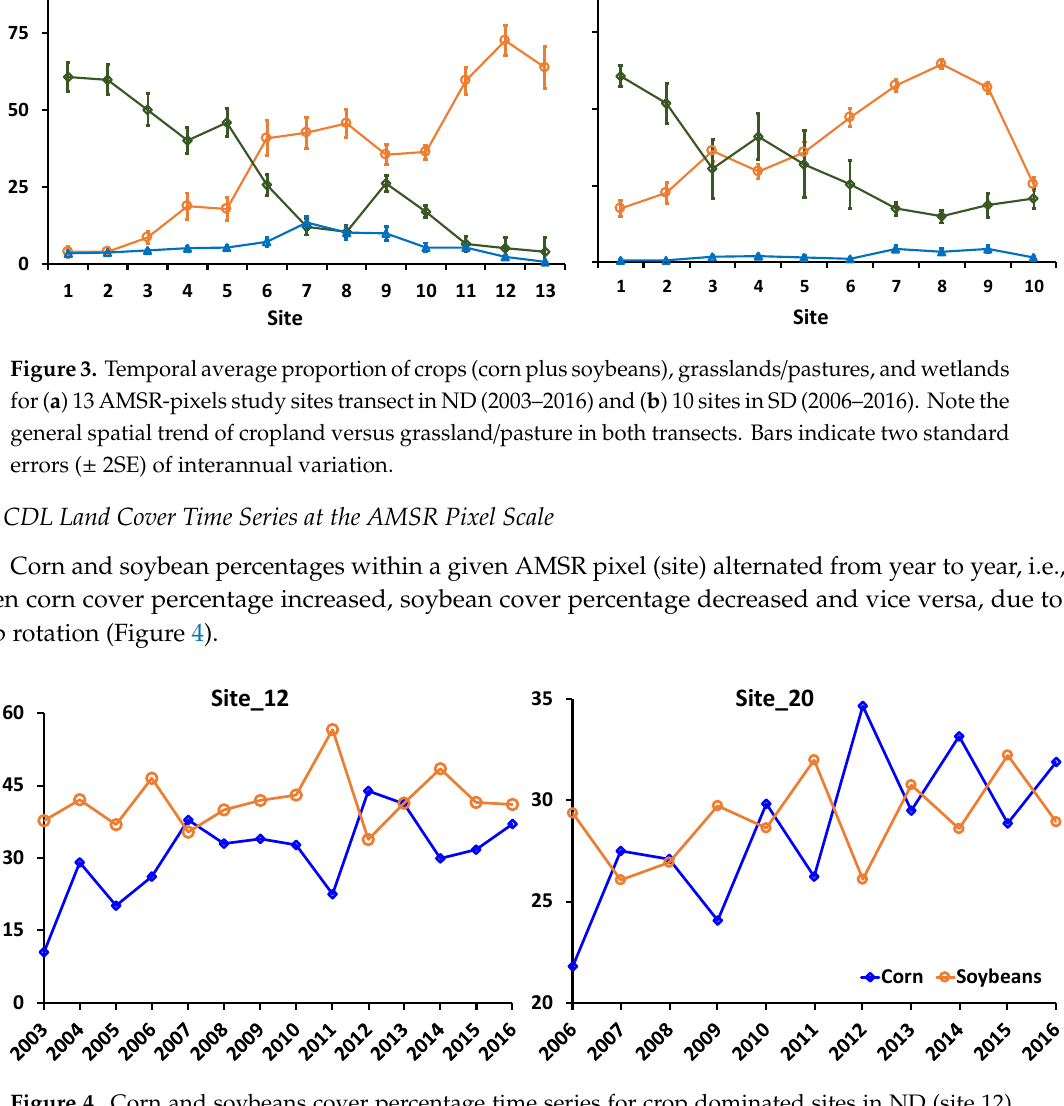
Figure 4. Corn and soybeans cover percentage time series for crop dominated sites in ND (site 12) and SD (site 20). Note the alternating crop rotation pattern. Note also the differences in axis scaling between the sites.